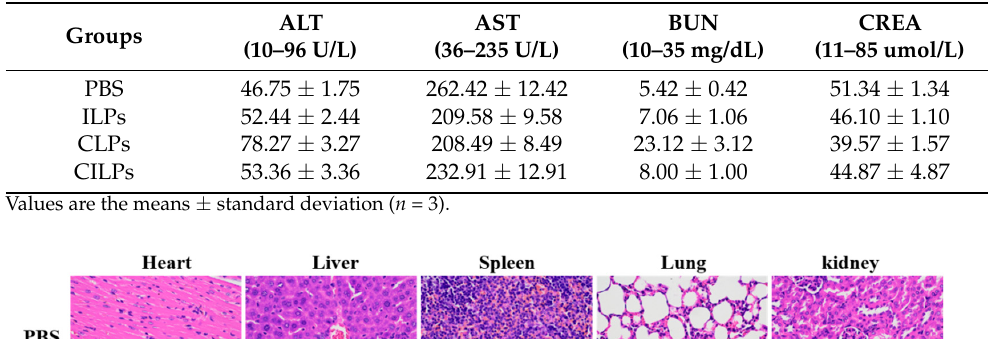
Table 3. The biochemical parameters of the liver and kidney.